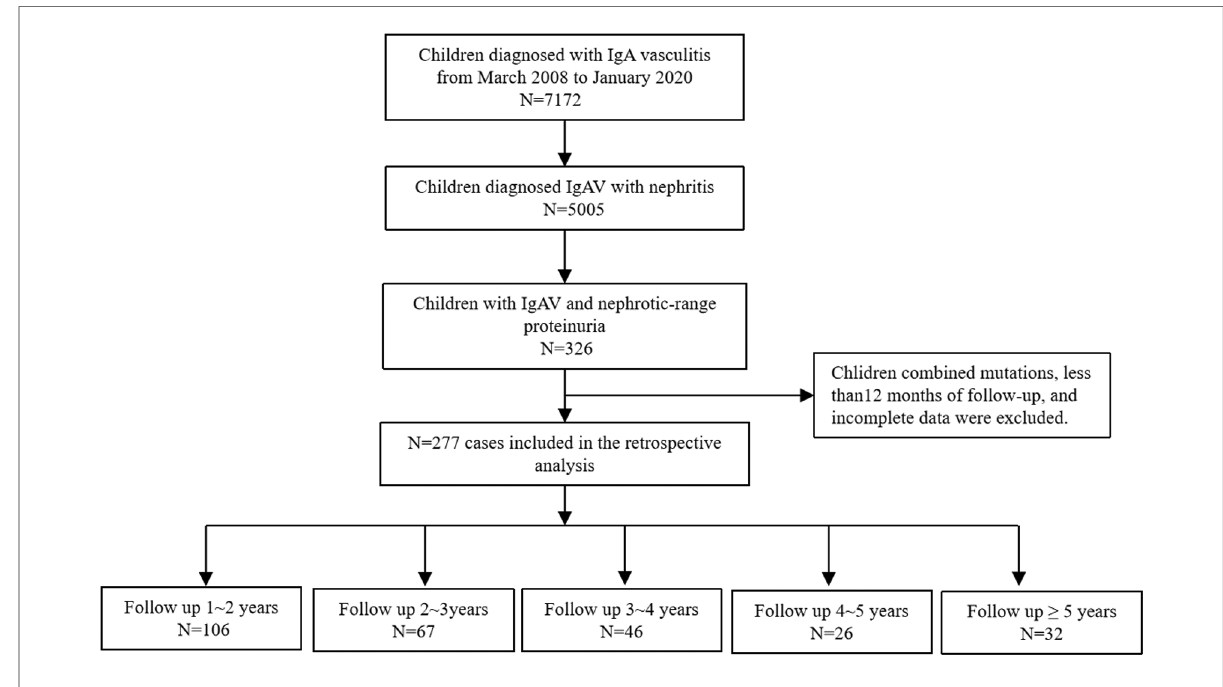
FIGURE 1 Flow chart for the enrolled